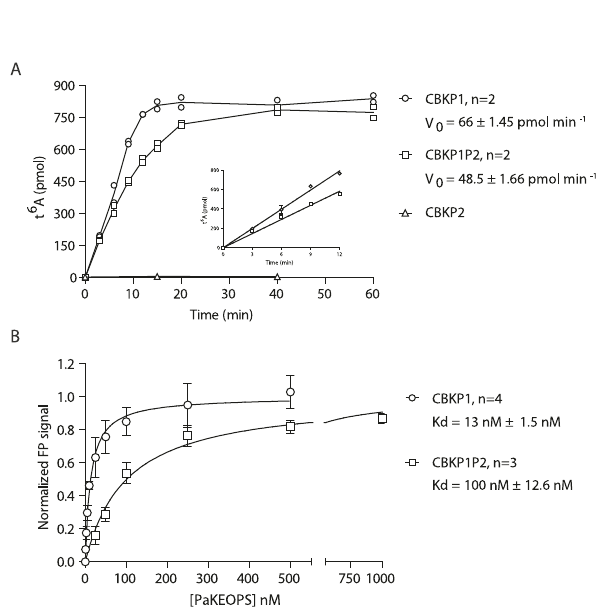
Fig. 7 | Enzymatic and tRNA binding activity of PaKEOPS complexes. A The t 6 A formation was measured for the three complexes at different time points and the linearpartofthecurve(inset)wasusedtocalculatethesteady-statevelocity(V 0 )of the reaction. All complexes were present at 1 µ M concentration. n =2 biologically independent experiments. B tRNA binding measurements using fl uorescence polarisation. Titration experiments were performed with fi xed concentration of fl uorescently labelled tRNA Lys (UUU) from Pyrococcus abyssi and increasing con- centrations of PaKEOPS complexes. The fl uorescence signal was normalized using B max values 108.5 and 193.6 for CBKP1P2 and CBKP1, respectively. n =4 (CBKP1) or n =3(CBKP1P2)biologicallyindependentexperiments.Dataarepresentedasmean values+/- standard deviation. Source data are provided as a Source Data fi le.